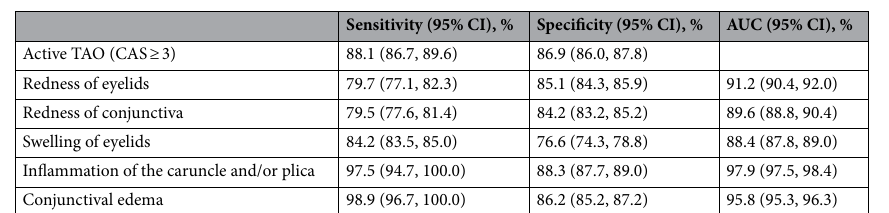
Table 3. Diagnostic accuracy of a ML-assisted system for active TAO and each inflammatory sign of CAS in the test set constructed from the dataset with consistent results. ML machine learning, CI confidence interval, AUC area under the curve, TAO thyroid associated orbitopathy, CAS clinical activity